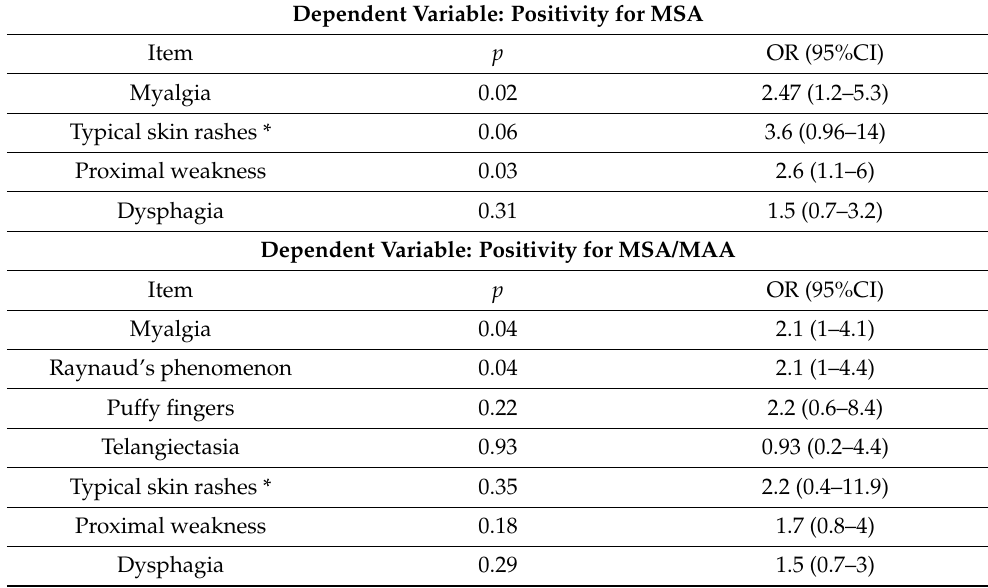
Table 2. Association of clinical features with positivity for